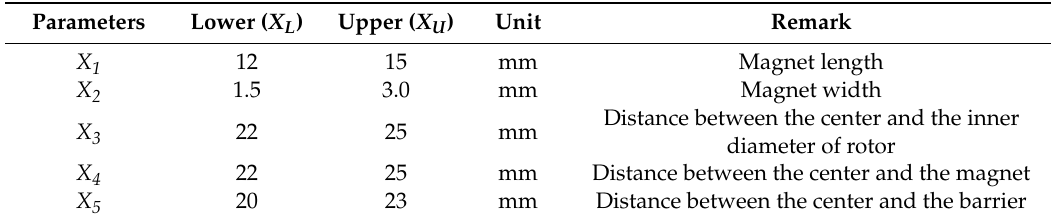
Table 2. Ranges of the design variables